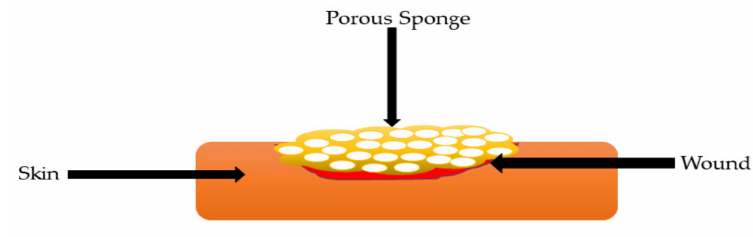
Figure 7. Microporous Sponge on Skin